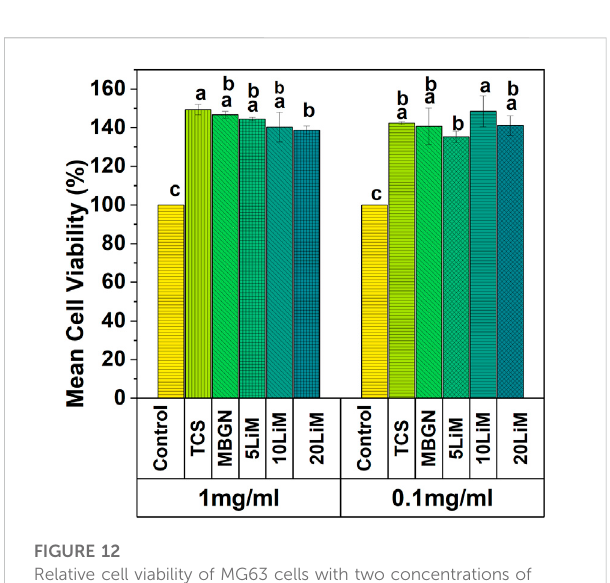
FIGURE 12 Relative cell viability of MG63 cells with two concentrations of sol-gel synthesized TCS, and MBGNs doped with various concentrations of Li at 48 h. Means that do not share a letter are signi fi cantly different from each other ( p <